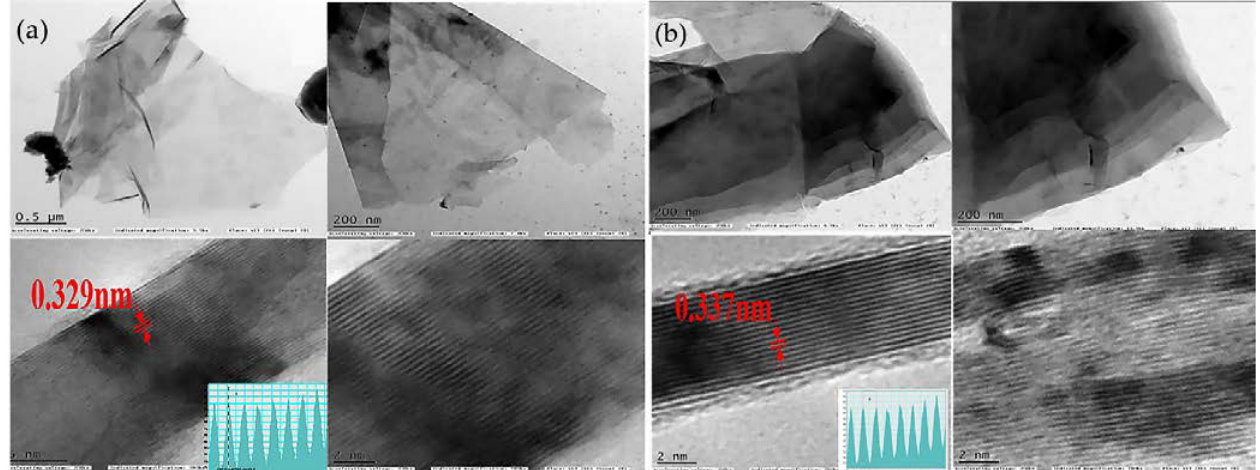
Figure 11. TEM micrographs of ( a ) Ti x Ta (4−x) AlC 3 MAX phases and ( b ) Ti x Ta (4−x) C 3 MXene. Reprinted with permission from [64].